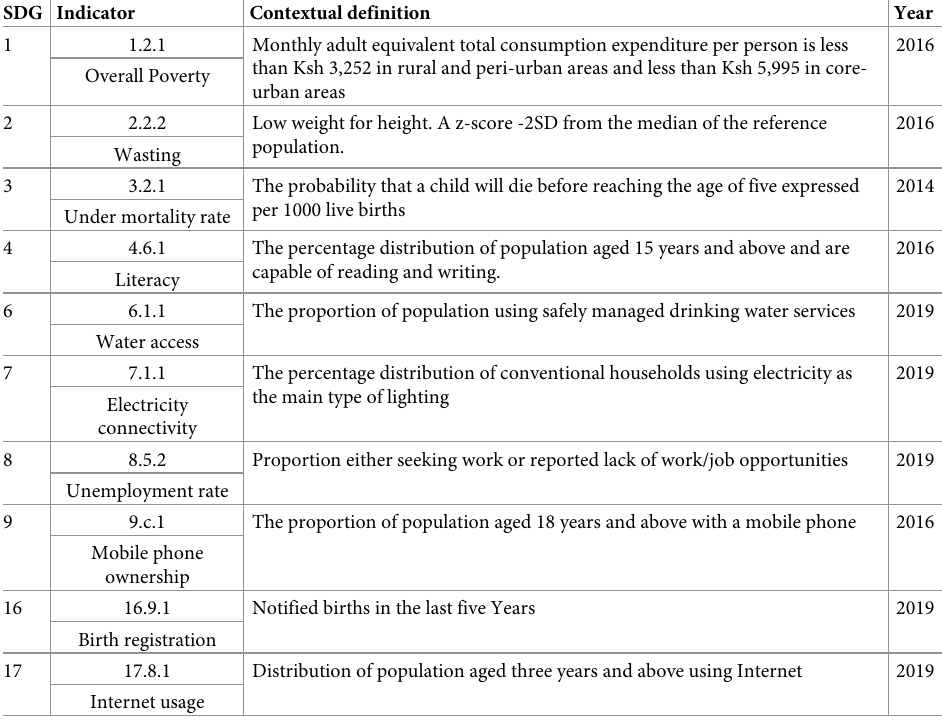
Table 2. Selected Sustainable Development Goals (SDGs) indicators that were correlated with spatial access met- rics to the nearest urban centre in Kenya. SDG